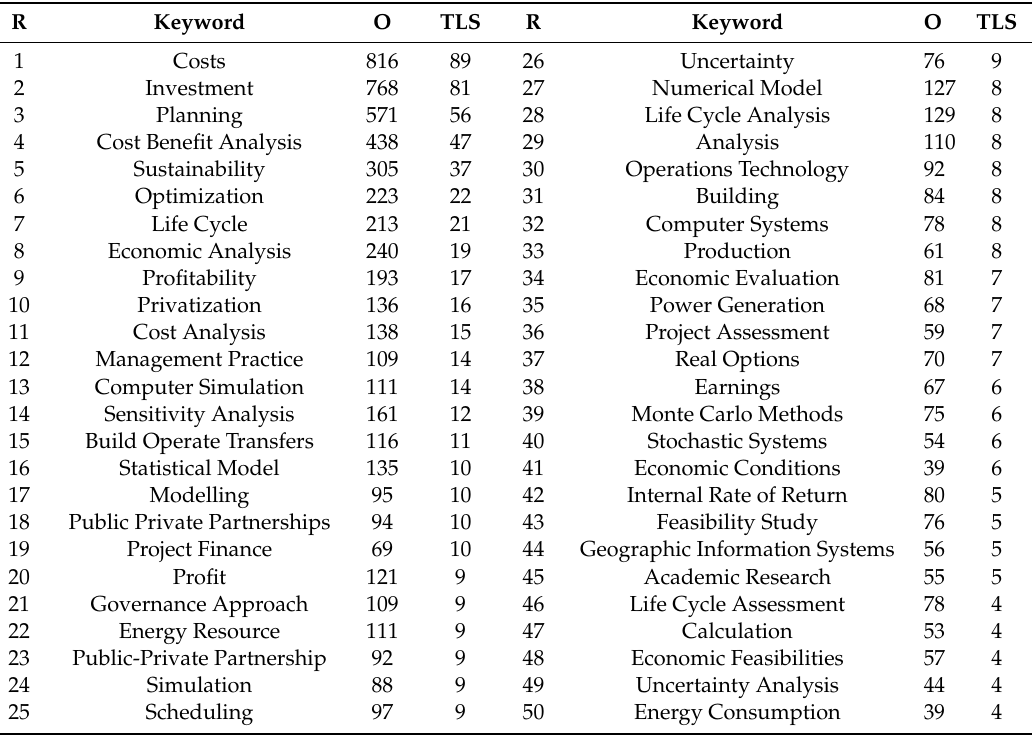
Table 8. Cluster 4. Top 50 keywords